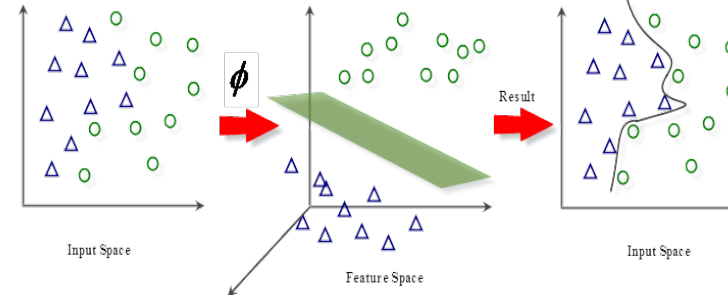
Figure 2. Concept of input space, mapping function and feature